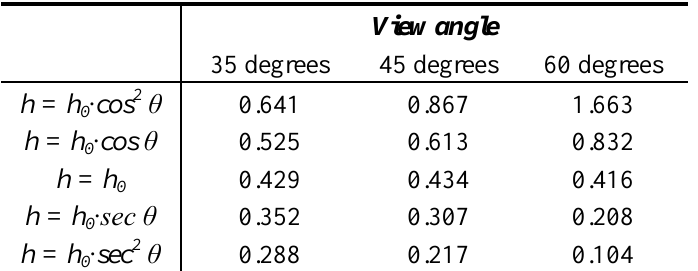
Table 1. Surface parameters obtained through inversion of H-polarized TB observations acquired over bare soil